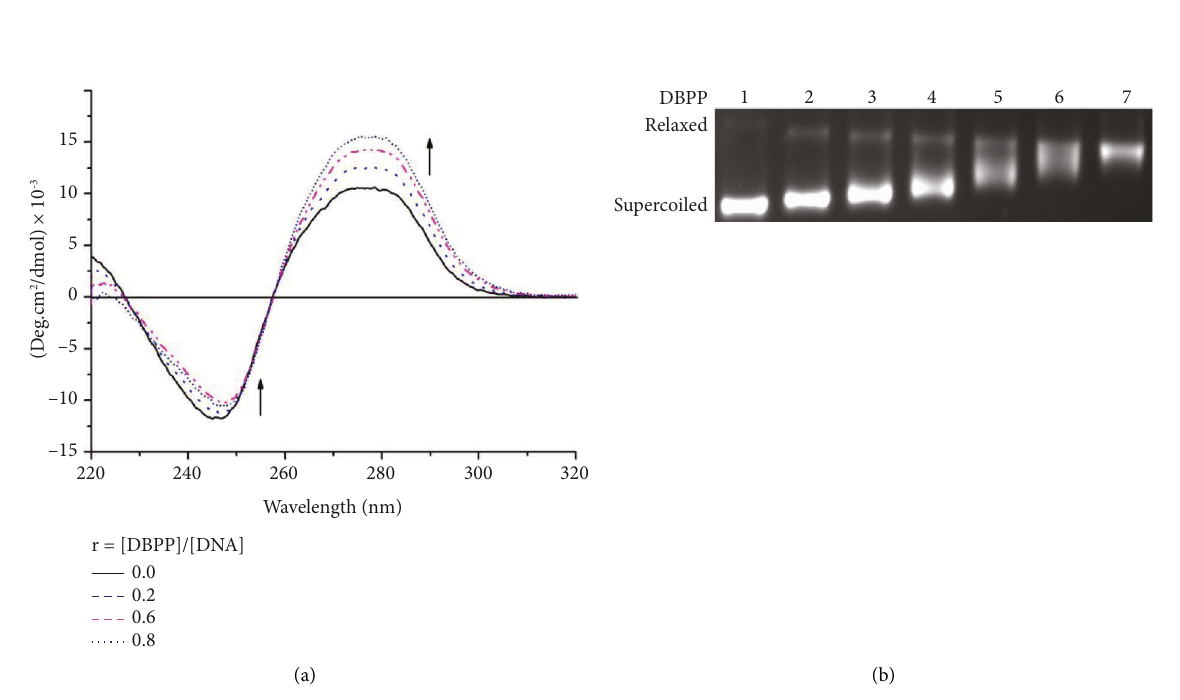
Figure 3: (a) CD spectra of CT-DNA (0.1mM) in the presence of DBPP at different [BPP]/[DNA] molar ratios after incubation at 37 ° C for 24h in buffer (5.0mM Tris-HCl, 50mM NaCl, pH 7.4), and (b) agarose gel electrophoresis patterns of pUC19 plasmid DNA incubated with DBPP at 37 ° C for 24h Lane 1, DNA control, lanes 2–7, r i � 0.30, 0.60, 0.90, 1.20, 1.50, and 1.60,